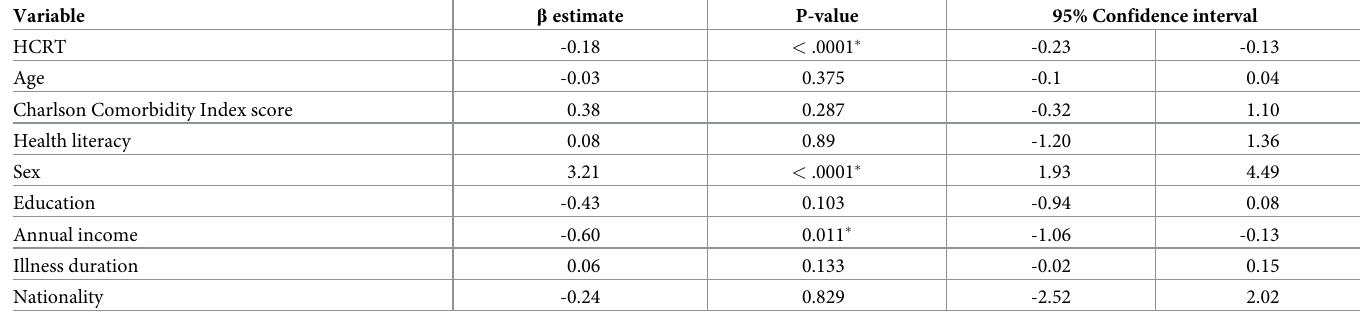
Table 2. Multiple linear regression for the association between patient health questionnaire-9 (PHQ-9) scores and health care relationship (HCR) Trust scores. Variable